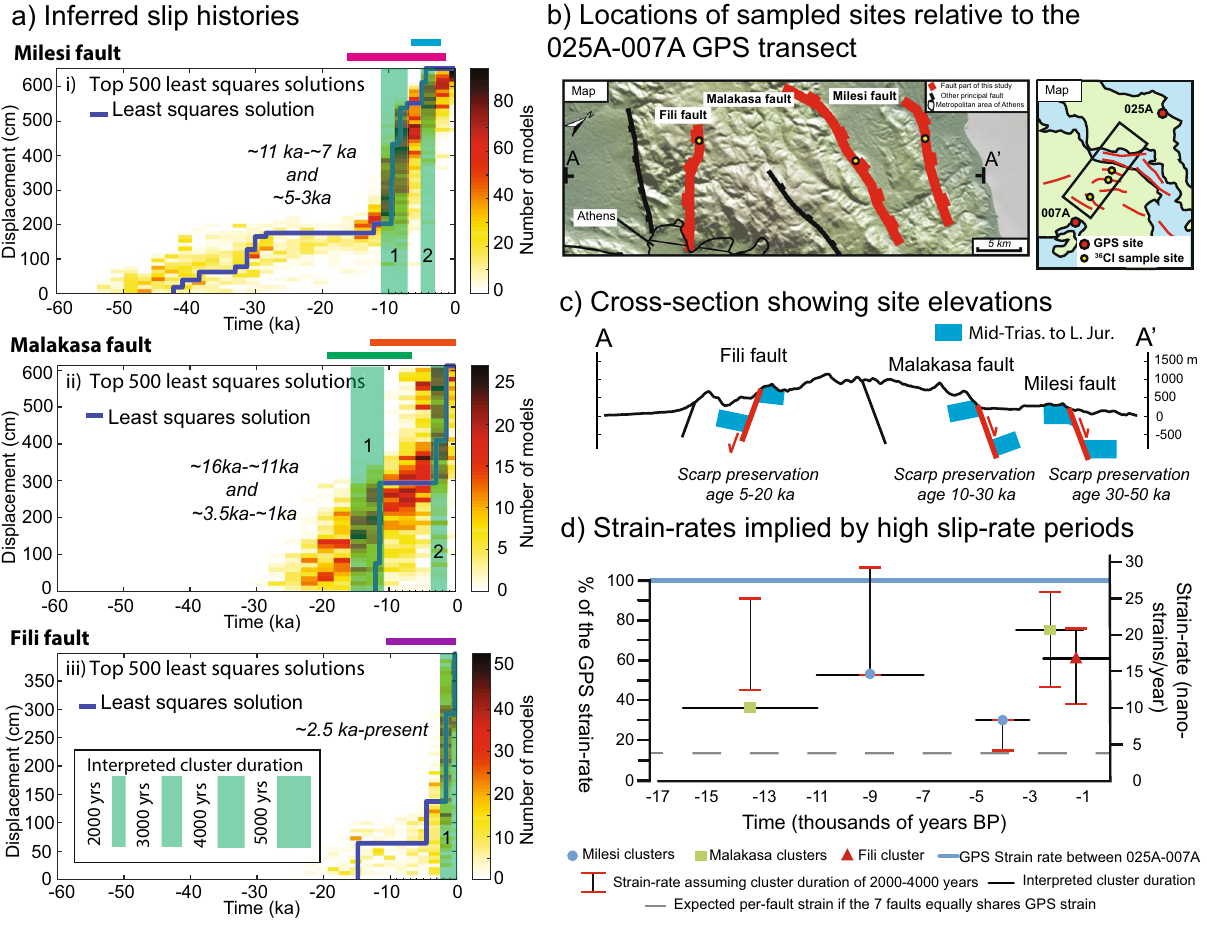
Figure 4. Swapping of the location of fault activity/strain accumulation across the strike of the normal fault system. We concentrate on the time since ~ 15 ka because slip is recorded at all 3 sites during this time period. ( a ) Slip-histories inferred from 36 Cl data interpreted to show the approximate durations of the principal clusters. ( b ) Locations of the faults relative to the 025A-007A GPS transect. ( c ) Cross-section showing the elevations and preservation ages of each site and geomorphic and geological offsets. ( d ) Strain rates implied by high slip-rate periods; strain-rates in each cluster are calculated over the interpreted duration of the cluster, as shown in ( a ); uncertainty for each strain-rate value is calculated assuming a cluster duration of 2000 kyears and 4000 kyears. We reject the hypothesis that each of the seven principal faults slip at a constant rate taking up 1/7 (~ 14%) of the regional strain-rate because the required clustered durations are not consistent with the inferred least squares slip histories. We interpret the existence of earthquake clusters that are out-of-phase on faults located across from each other suggesting that only a few faults are active at any one time on a millennial timescale and fault activity swaps across strike to maintain the regional